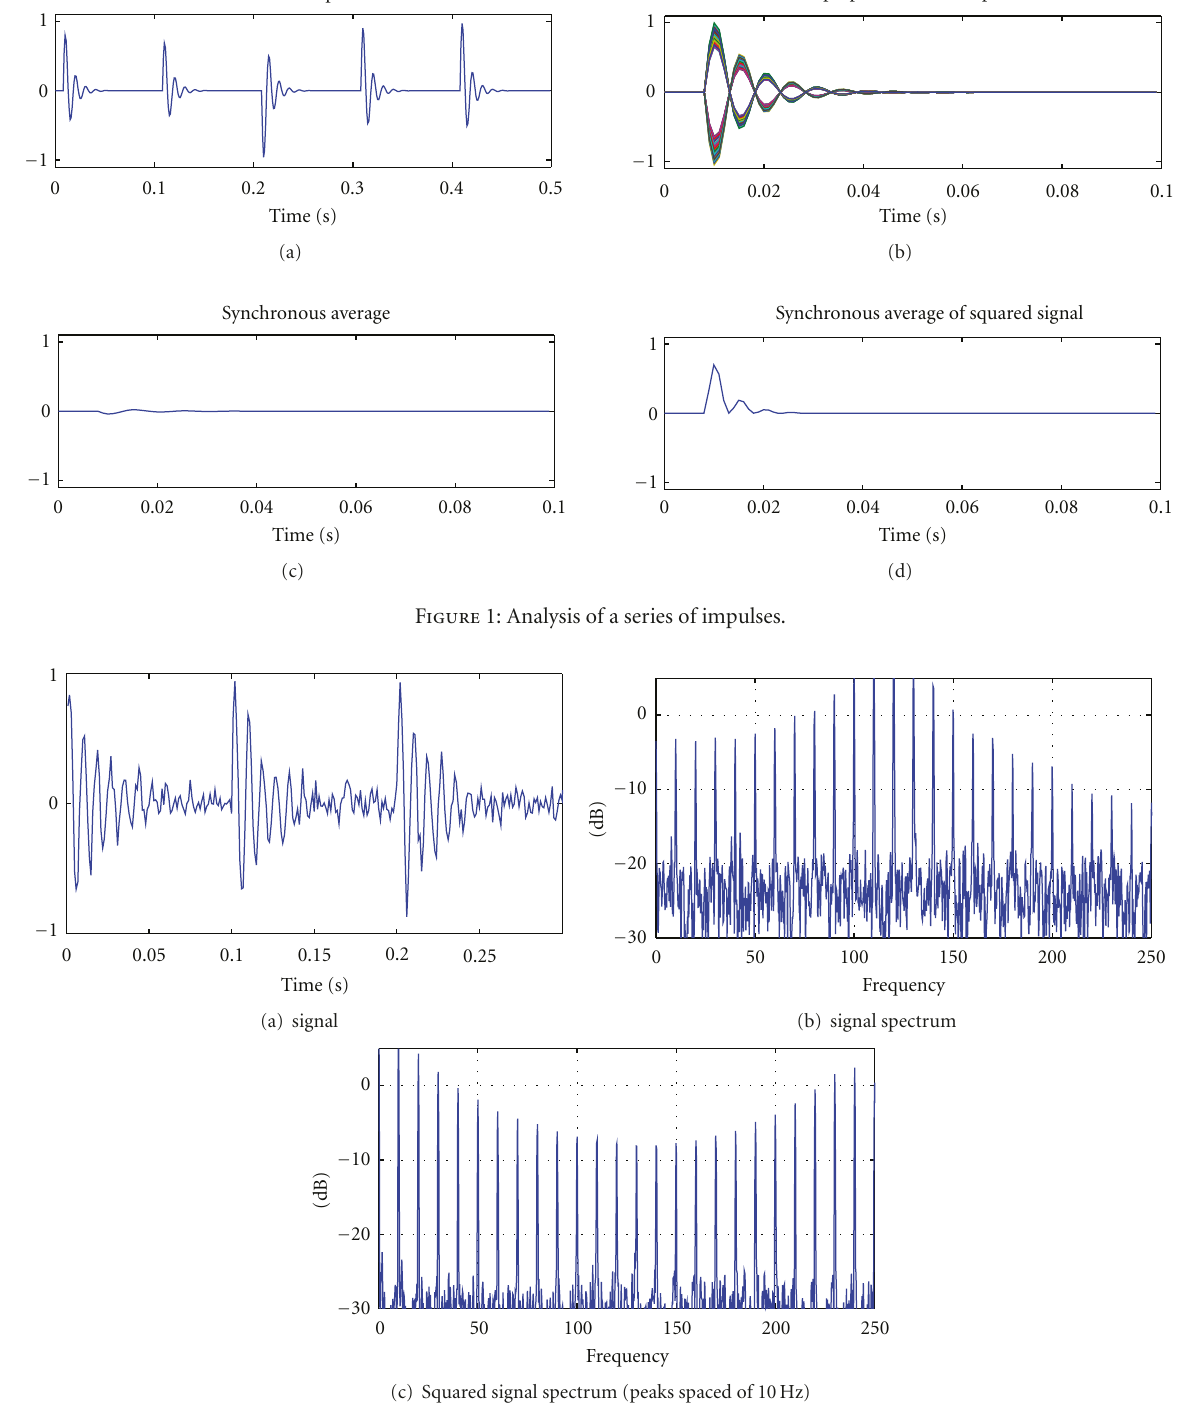
(c) Squared signal spectrum (peaks spaced of 10Hz) Figure 2: Impacts with no phase variation for sine